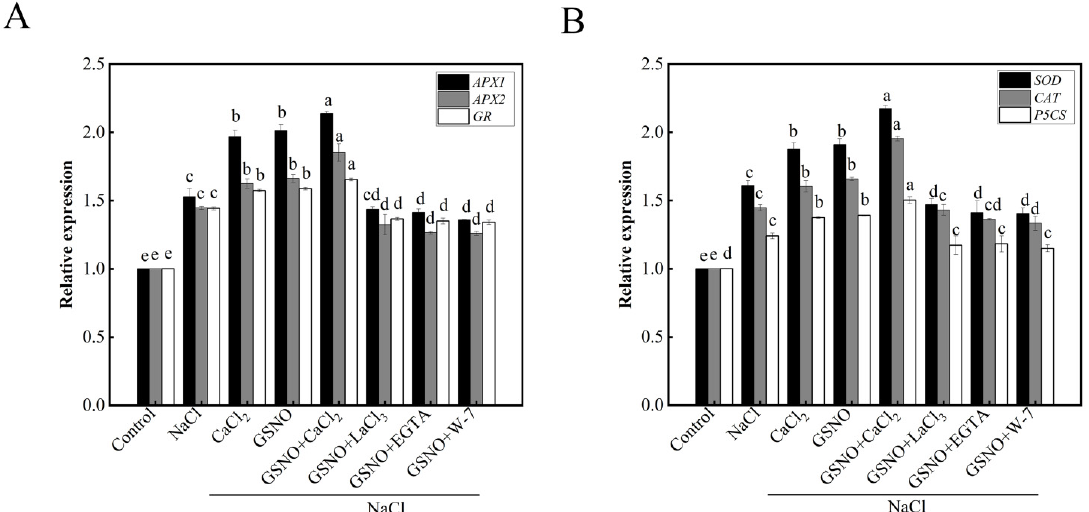
Figure 6. Effects of exogenous NO and Ca 2+ /CaM on antioxidant synthesis-related genes in tomato seedlings under salt stress. ( A ): Relative expression of APX1 , APX2 , and GR ; ( B ): relative expression of SOD , CAT and P5CS . The values (means ± SE) are the averages of three independent experiments ( n = 15). The columns labeled with different small letters indicate significant differences between treatments by Tukey’s multiple comparison test ( p < 0.05).